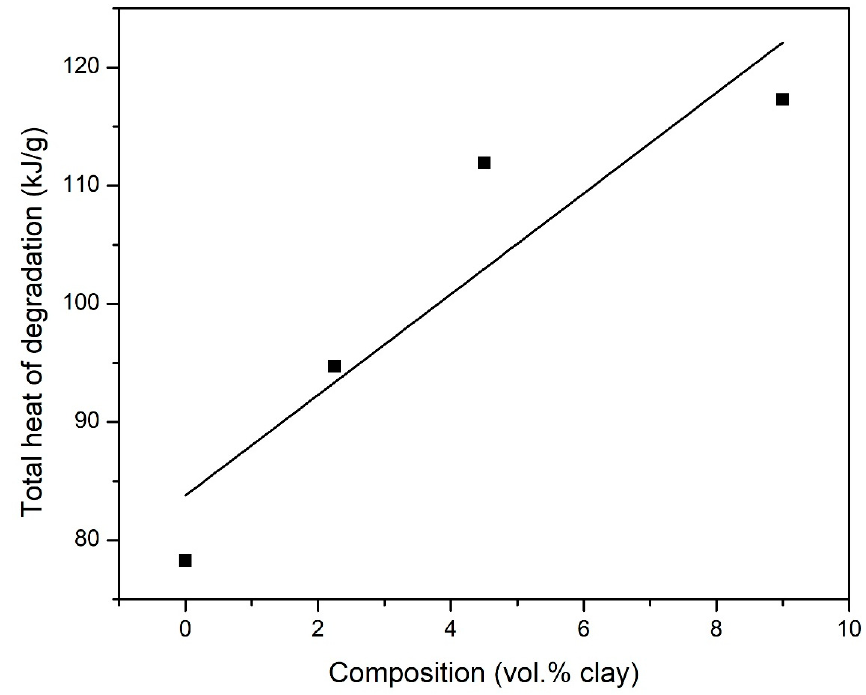
Figure 11. Variation of the total heat released during the degradation of PI–NGS–Clay samples with changing vol.% clay as measured by DSC in nitrogen atmosphere.